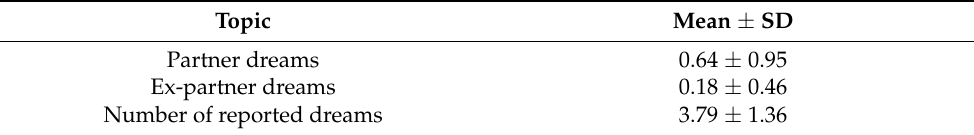
Table 2. Number of partner and ex-partner dreams per person (N = 425